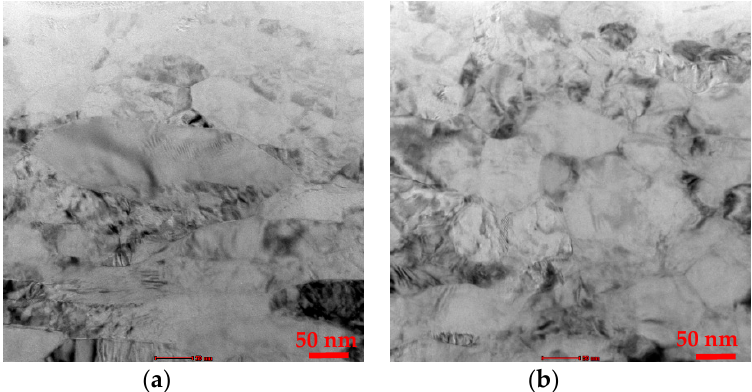
Figure 7. Bright-field top surface TEM images of the UNSM-25 ( a ) and UNSM-300 ( b ) samples.